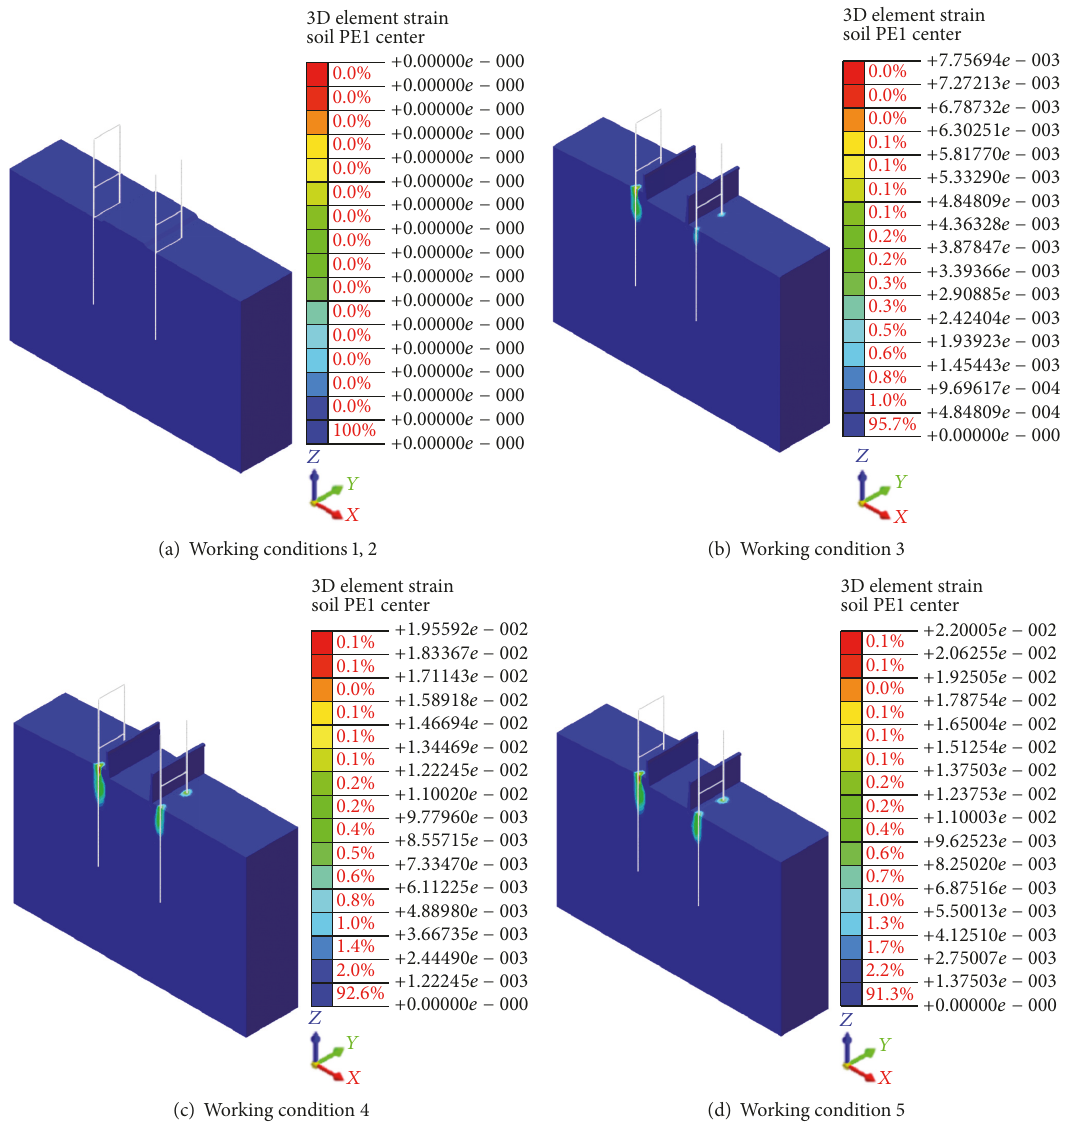
Figure 27: Maximum principal plastic strain of foundation soil under different working conditions.